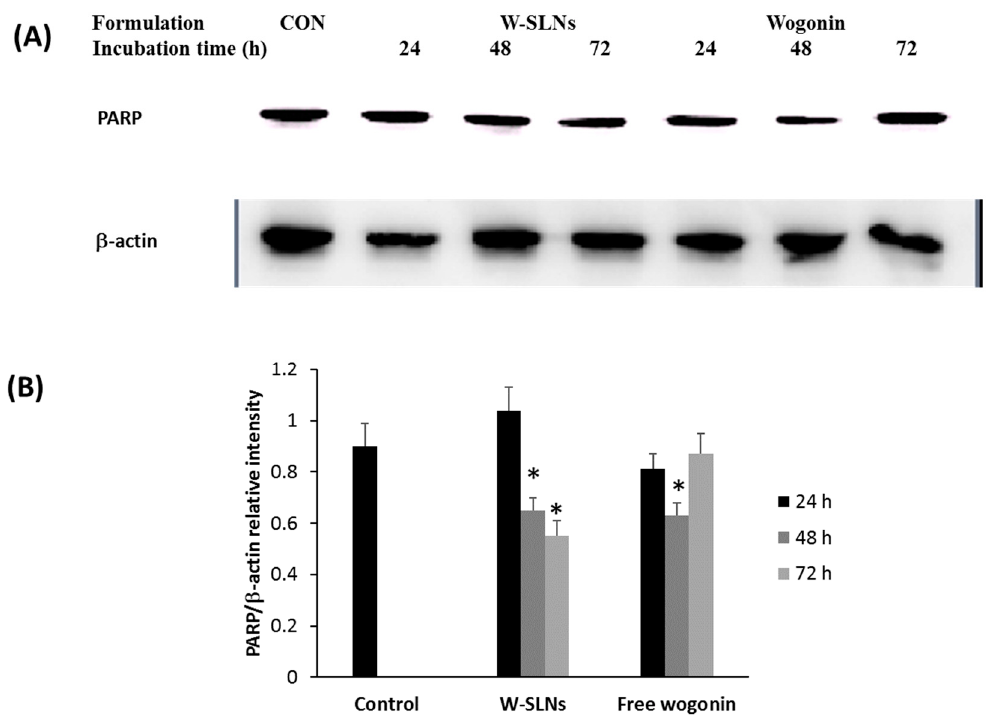
Figure 8. The effect of W-SLN and wogonin on the expressions of poly (ADP-ribose) polymerase (PARP) in MCF-7 cells. ( A ) Western blot assay of PARP and β -actin of MCF-7 cells were incubated with DMEM (CON), W-SLN, and wogonin for 24, 48, and 72 h; ( B ) PARP/ β -actin relative intensity of control, W-SLNs, and free wogonin. * p > 0.05 shows significant difference with control.